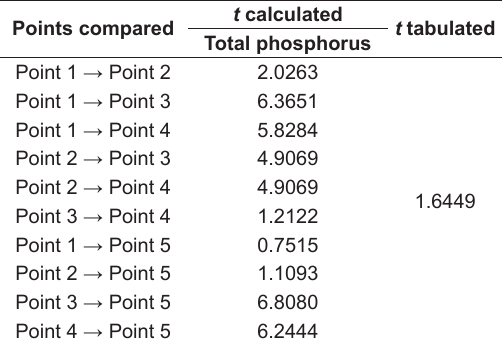
Table 1. Comparison between points in total phosphorus parameter during the rainy